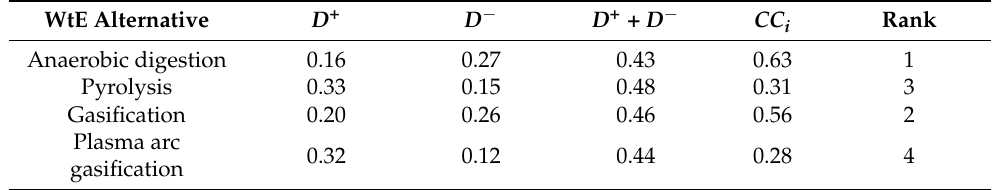
Table 11. Computations of D + , D − and CC